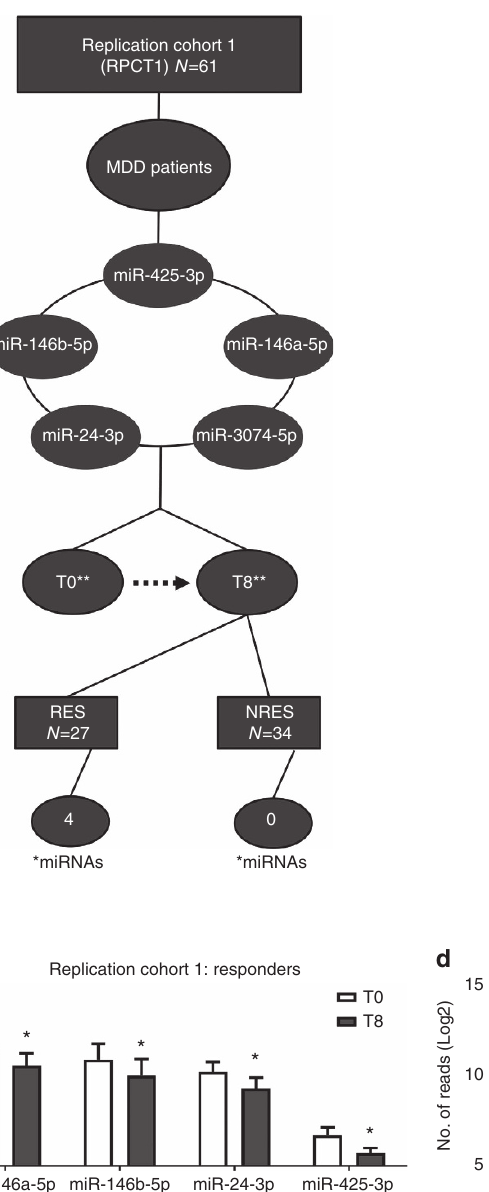
Figure 2 | Independent replication cohorts. ( a , c ) Experimental design. Replication cohorts (RPCT1 and RPCT2), baseline (T0), 8 weeks of treatment (T8), responders (RES) and nonresponders (NRES). *Number of significant miRNAs. **Patients were treated with escitalopram or nortriptyline. ( b , d ) Log2 expression of miRNAs after 8 weeks of antidepressant treatment. * P o